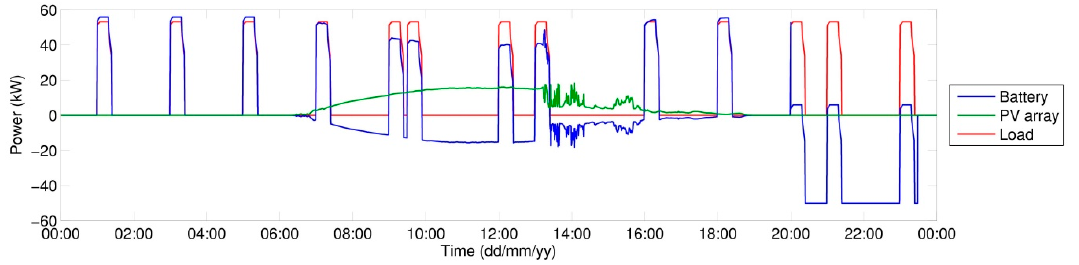
Figure 22. Power profile for simulation of individual states, scenario B, detailed view of 4th day.